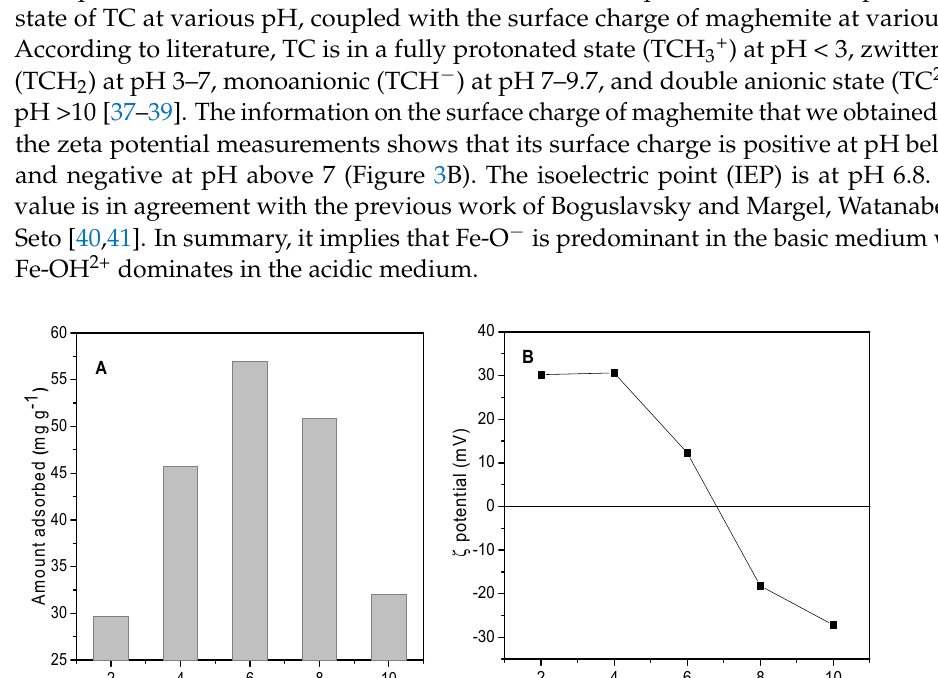
Figure 2. The PXRD diffraction pattern of as-prepared maghemite nanoparticles with the hkl indices characteristic for Fd-3m space group.